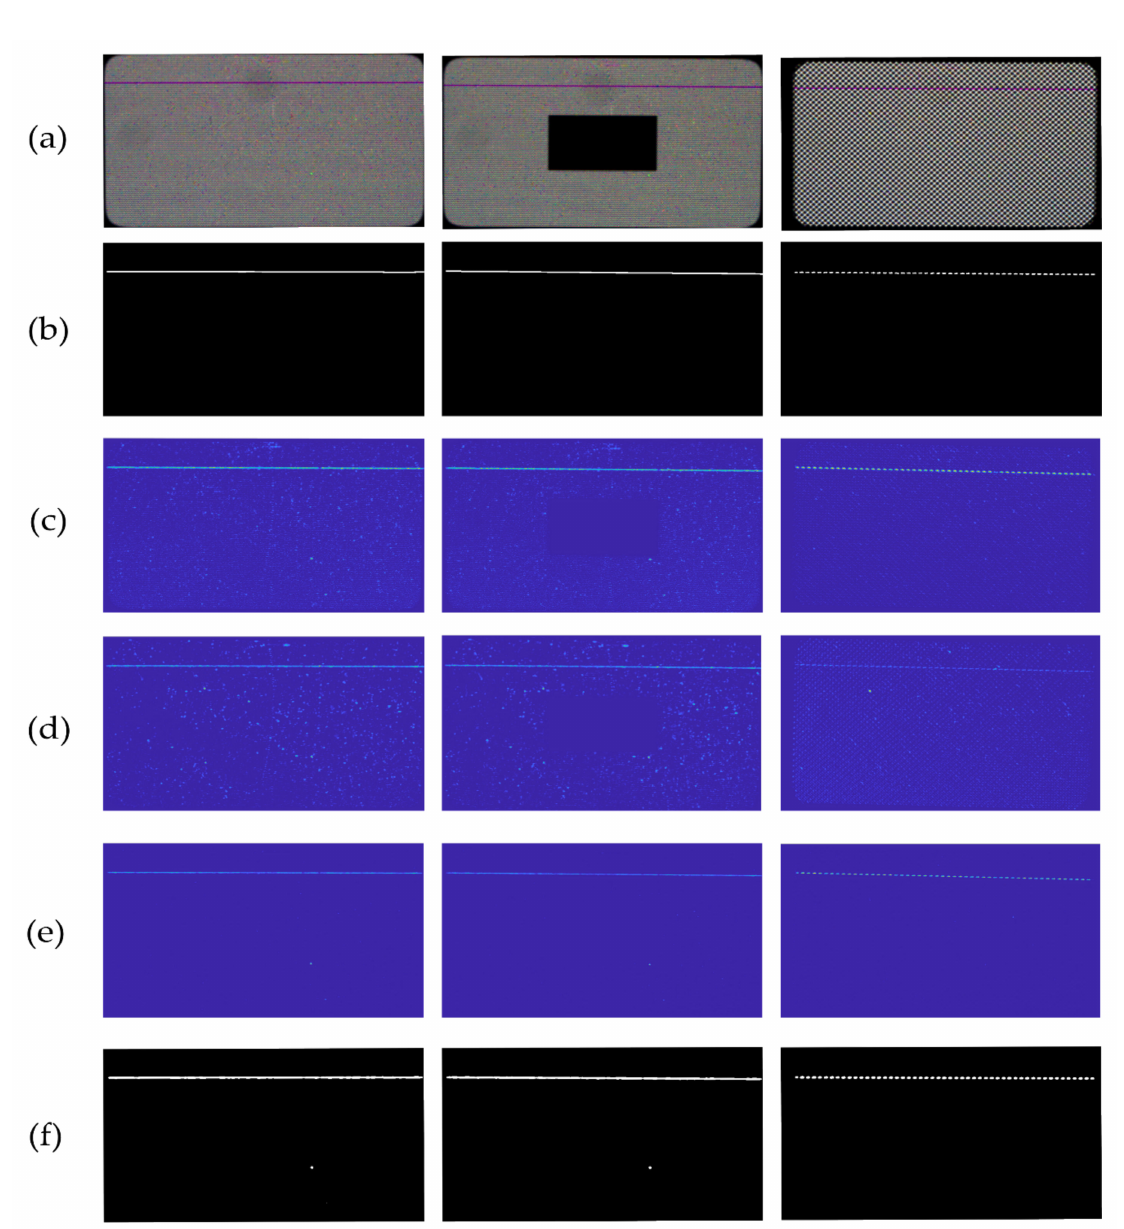
Figure 4. Stable feature defect detection results. ( a ) is the original image; ( b ) is the GT map; ( c ) red-green fusion feature map; ( d ) blue-yellow fusion feature map; ( e ) color fusion saliency map; ( f ) Threshold segmentation result